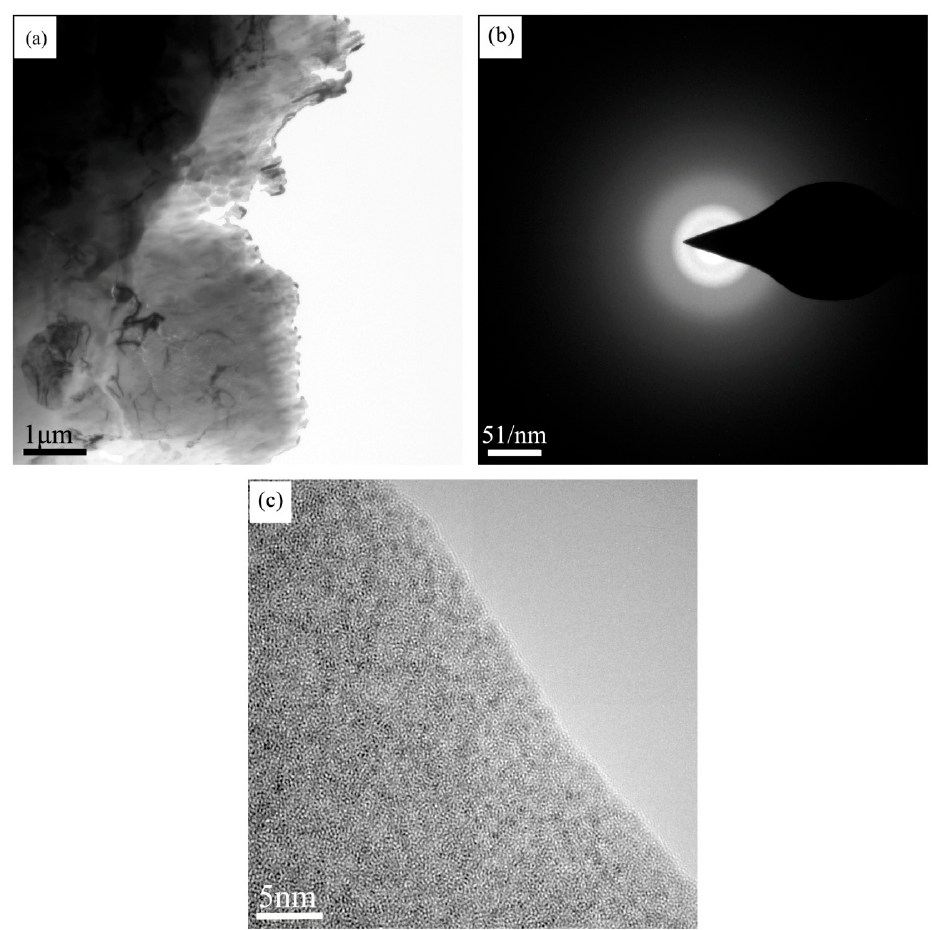
Figure 7. ( a ) BF-TEM; ( b ) corresponding SAED; and ( c ) HRTEM images for the powder particles after ball milling for 40 h at 500 rpm.